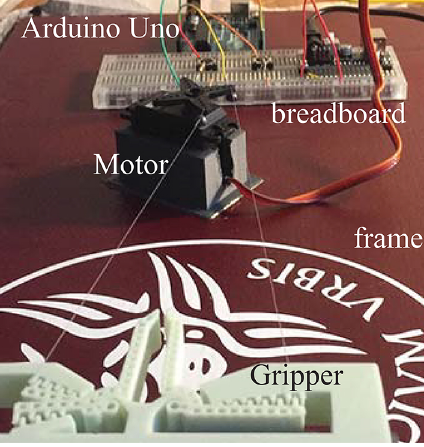
Figure 3. A picture of the experimental layout (first